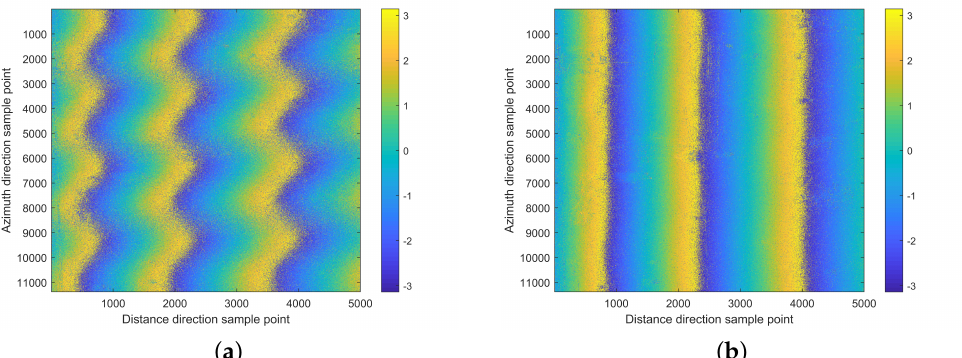
Figure 9. The comparison of interference fringe results. ( a ) The comparison method; ( b ) the pro- posed